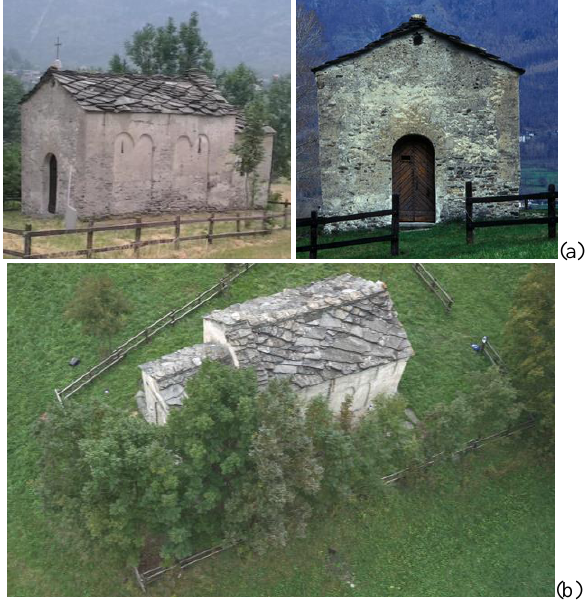
Figure 2.(a) Two detailed view of the S. Maria’s Chapel; in